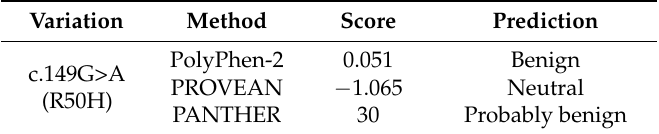
Table 4. Prediction of non-synonymous polymorphisms in dogs by PolyPhen-2, PROVEAN and PANTHER. Variation Method Score Prediction PolyPhen-2 0.051 Benign c.149G>A (R50H) PROVEAN − 1.065 Neutral PANTHER 30 Probably benign